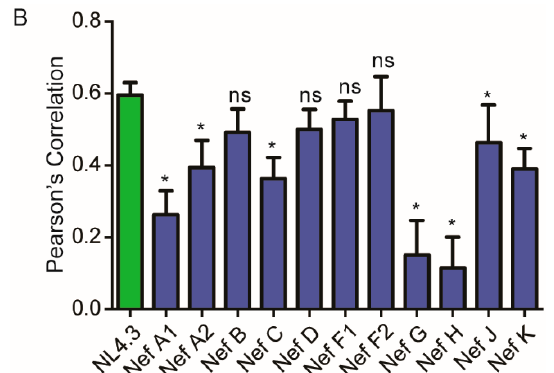
Figure 3. Differing trans-Golgi localization of Nef proteins from reference strains of HIV-1 group-M subtypes. ( A ) CD4 HeLa cells were transfected with plasmids encoding eGFP-tagged Nef proteins from different HIV-1 subtype reference strains. Cells were fixed in 4% paraformaldehyde, immunostained for trans-Golgi network integral membrane protein 46 (TGN46), and imaged on a Leica DMI6000 widefield microscope on the 100 × objective; scale bar = 10 µ m, green = Nef–eGFP, red = TGN46. Right panel insets represent a 4 × magnification of the selected area. Scale bar = 5 µ m. ( B ) Images were deconvolved, and colocalization analysis was completed using the Pearson’s Correlation with the JaCoP Image J plugin. Mean (+/ − SD) Pearson’s correlations of Nef and TGN46 colocalization are illustrated from three independent experiments. (ns: non-significant; * p ≤ 0.05; SD: standard deviation).